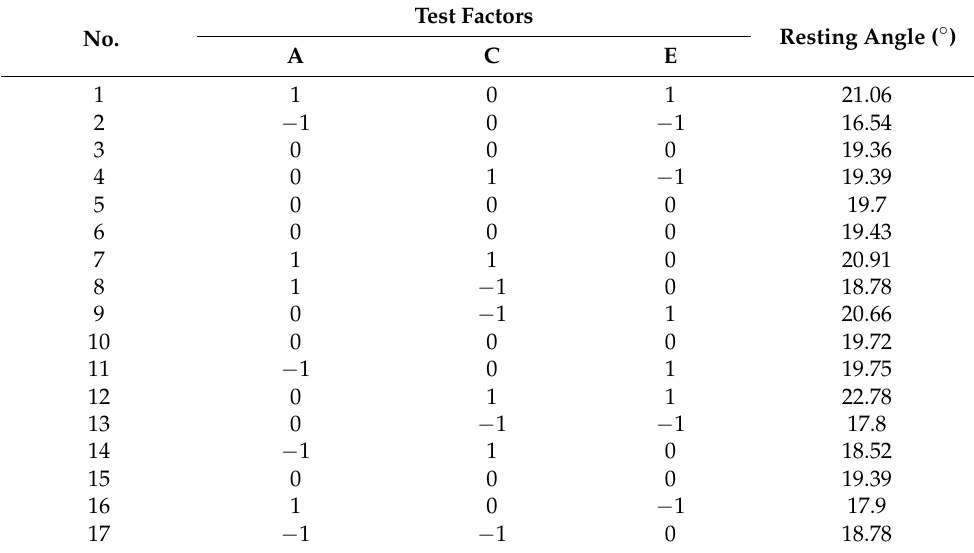
Table 6. Scheme and results of Box-Behnken